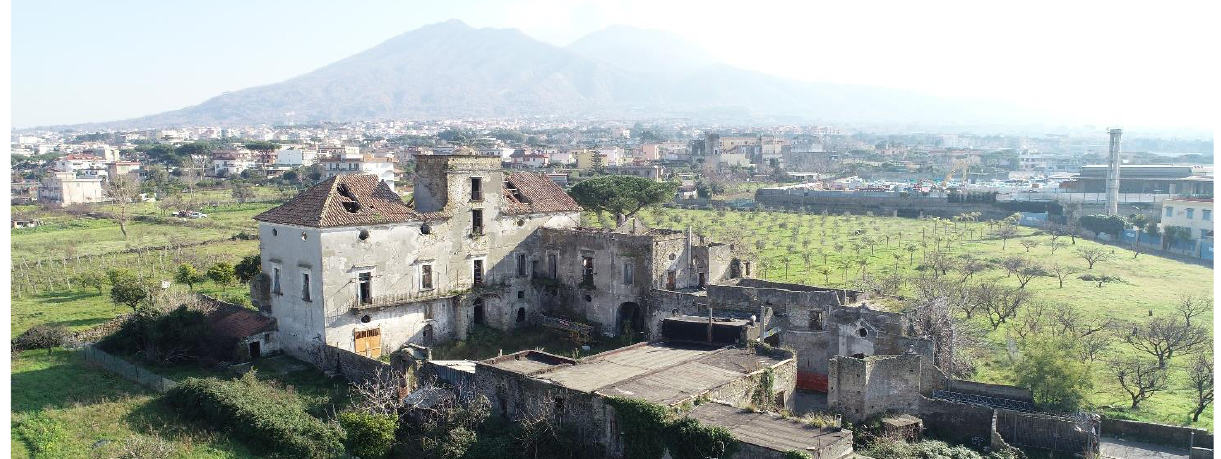
Figure 1. An aerial view of Masseria Rota. (Marco Facchini, M_Lab, Department of Architecture, Naples,